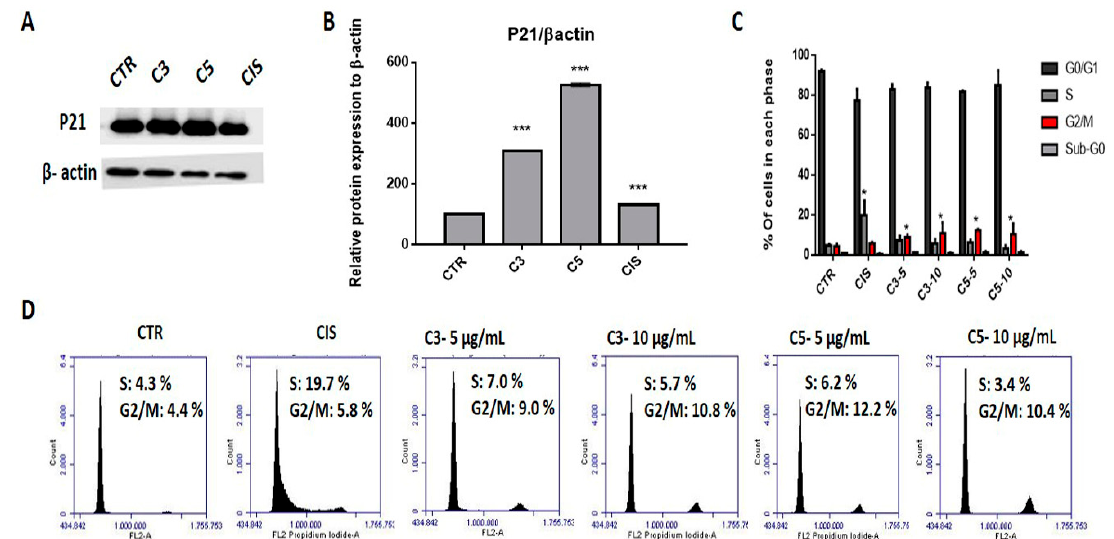
Figure 3. Cell cycle alterations in SiHa cells after exposure to C3 and C5 compounds ( A ) Western blot of p21 in SiHa cells upon C3, C5, and cisplatin treatments. ( B ) Densitometry of p21. ( C ) Cell cycle profile in SiHa cells. ( D ) Cell cycle phase distribution after treatment with C3 and C5. (*** p < 0.0001; * p < 0.05). C3: Ethyl acetate fraction; C5: Fraction enriched in acetogenin; Cis: cisplatin; DMSO: